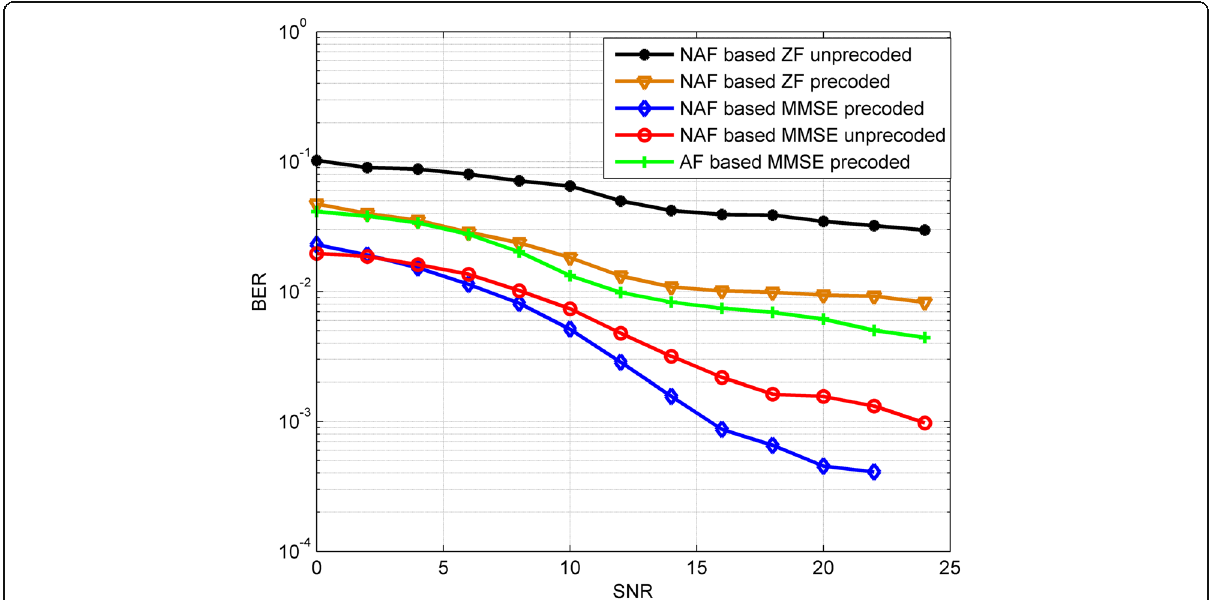
Fig. 4 The performance comparison of the existing unprecoded/precoded in an NAF and AF MIMO relaying